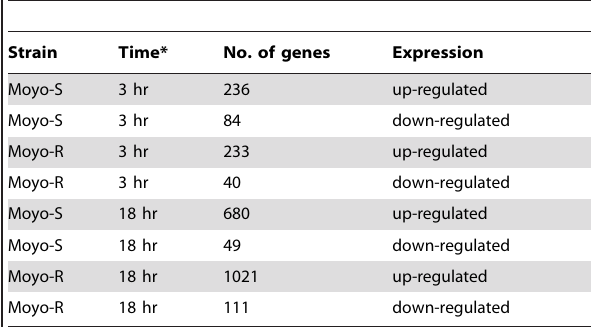
Table 1. Number of Aedes aegypti genes showing differential